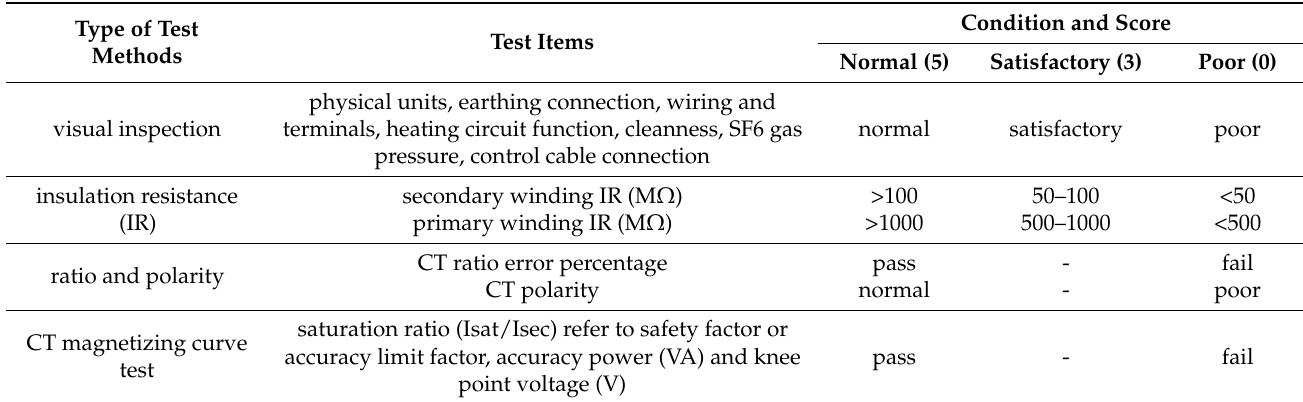
Table 5. CT testing methods and visual inspection.